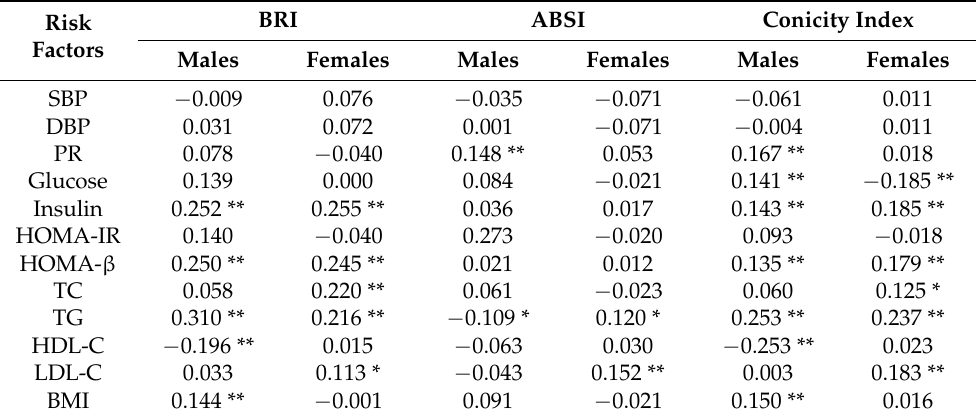
Table 2. Pearson correlation for anthropometric indices and cardiovascular risk factors of Ellisras young adults aged 21–30 years.